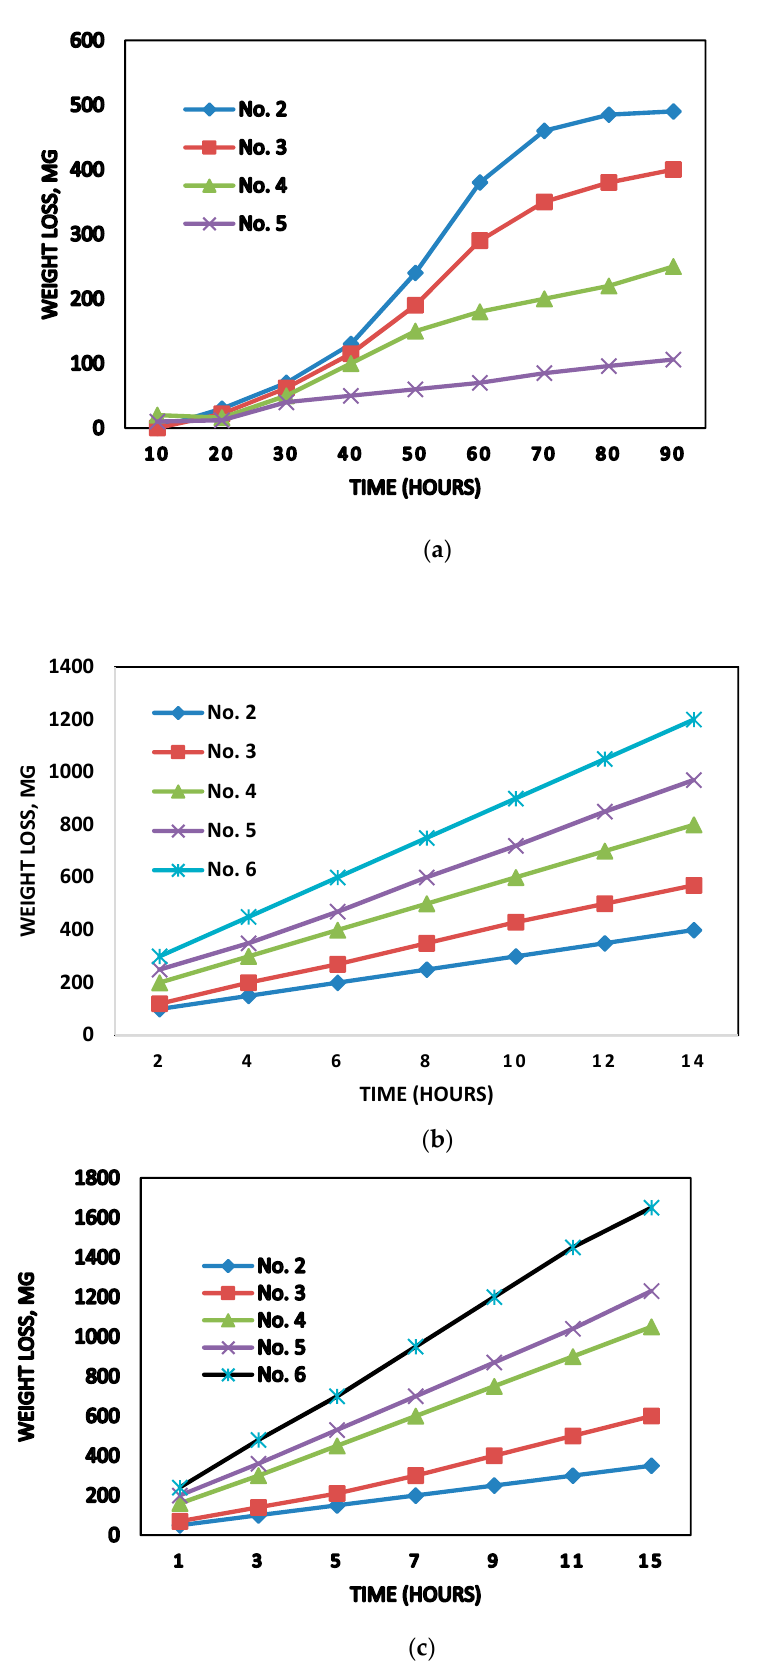
Figure 20. ( a ) Weight loss curves for the cavitation; ( b ) weight loss curves of the sediment erosion; ( c ) weight loss curves for the coalesced effect [47].